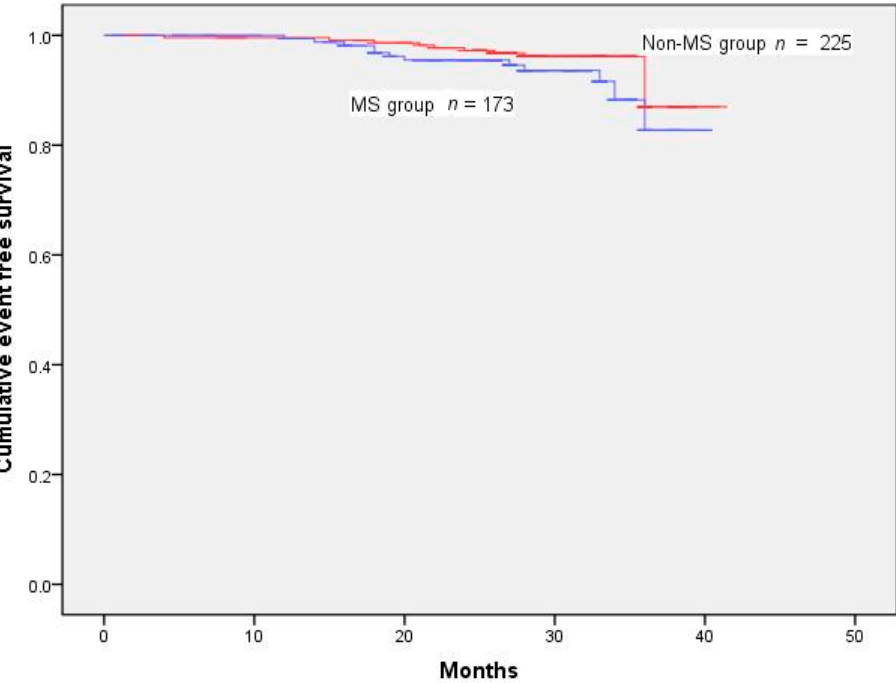
Figure 5. Cumulative survival rates censored for MI. Survival rates were similar between the groups (log-rank test p = 0.232).